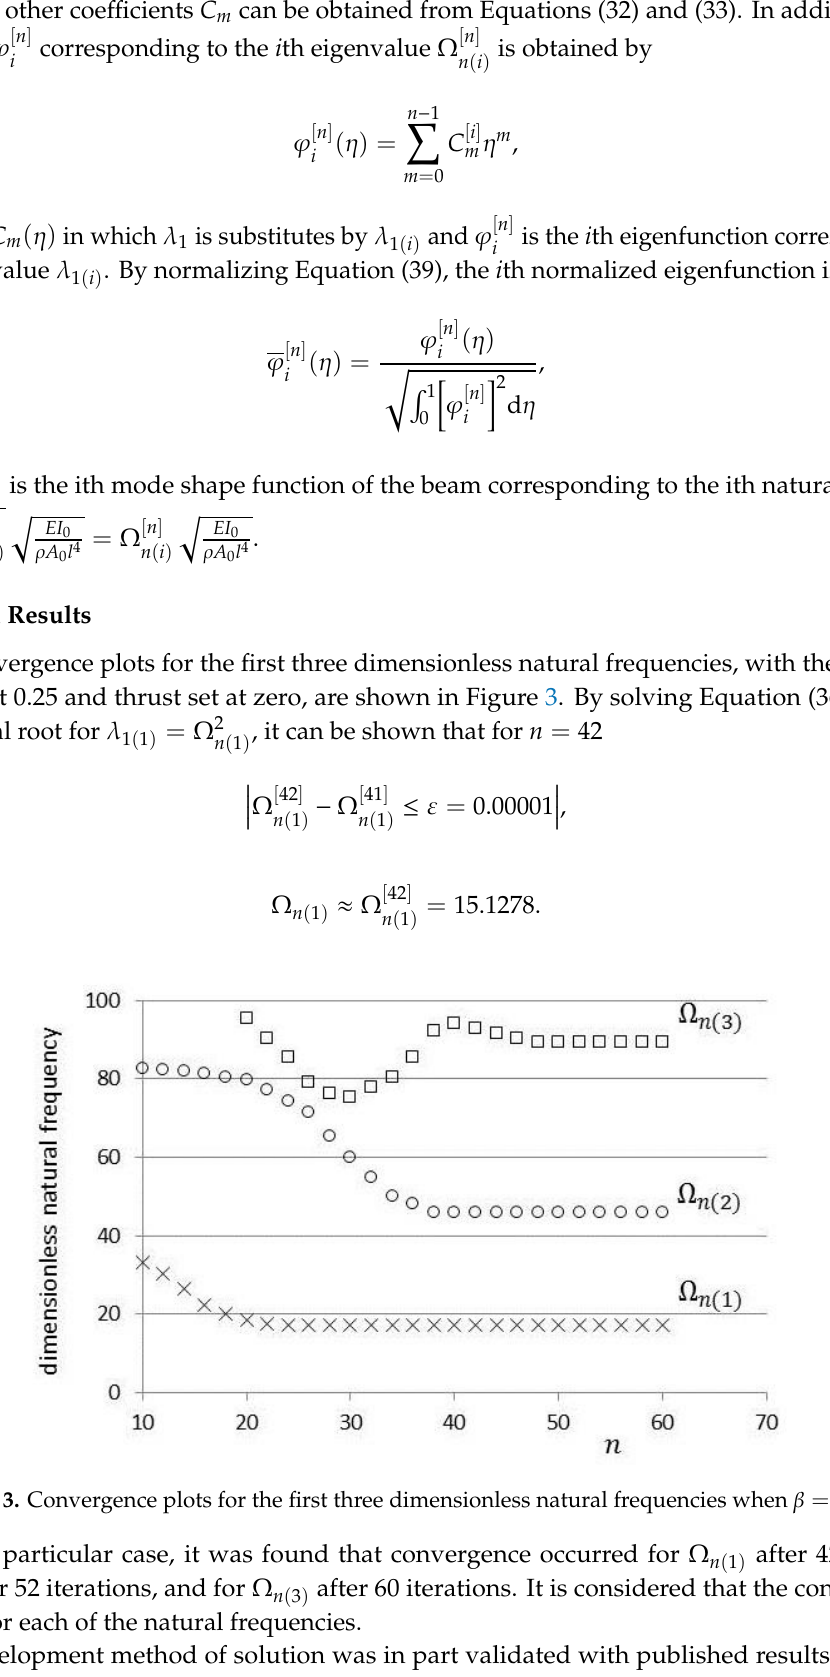
Table 1. Frequency parameters of a uniform beam with circular cross-section with free-free boundary conditions.